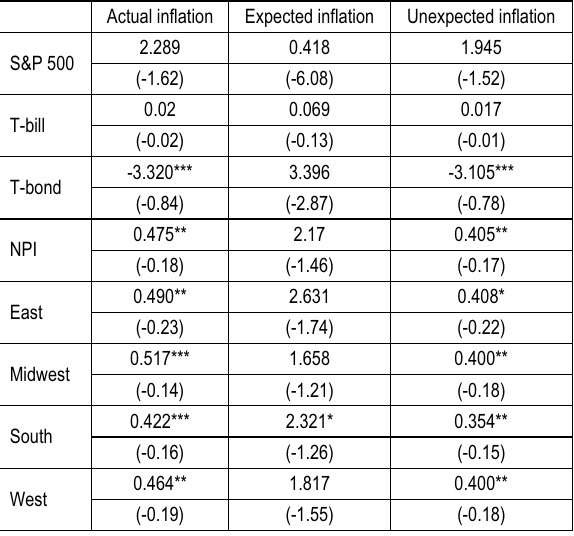
Table 6. Second half of